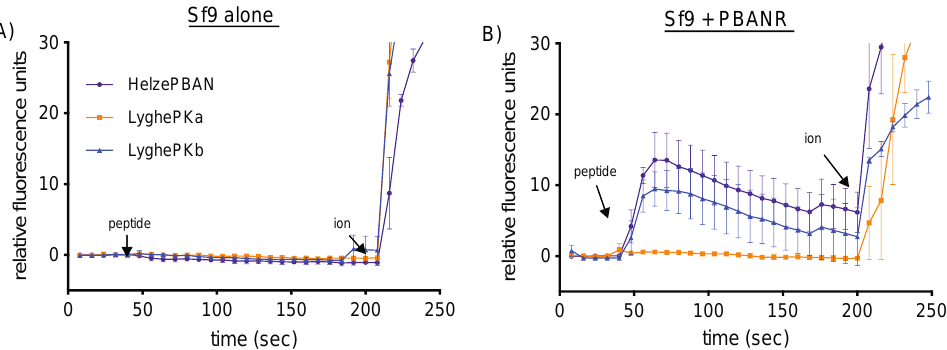
Figure 6. In vitro activation of a heterologously expressed PK2 receptor. Extracellular Ca 2+ -based intracellular fluorescence signals were quantified over time in ( A ) Sf9 cells alone and in ( B ) Sf9 cells stably expressing the B. mori PBAN receptor (PBANR). Peptides (1 μM) were added 40 s into the scan period with the positive control, 10 μM ionomycin (ion), added at 200 s. Each point is the mean value ± SEM of 25 individual cells in triplicate.